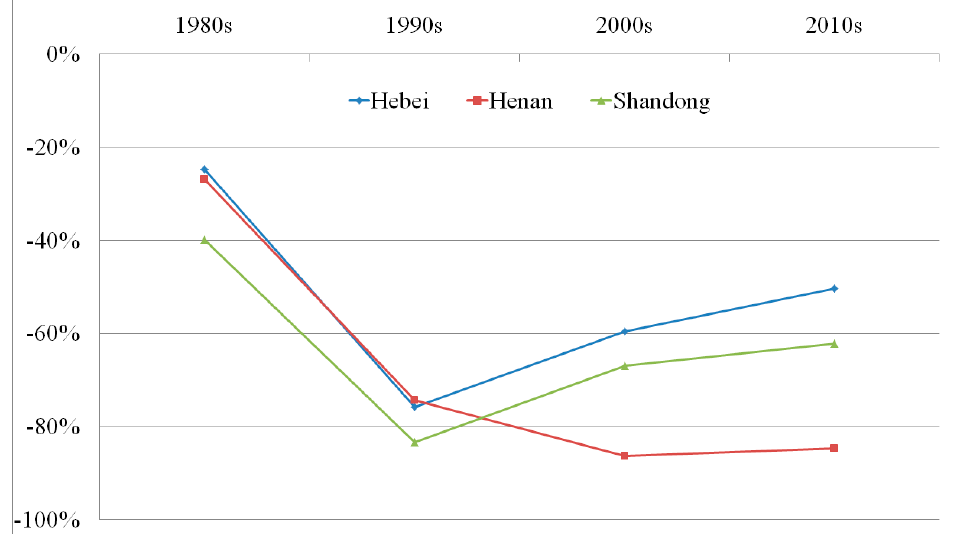
Figure 3. The decadal agricultural drought affected area changes (ADAC) during the period of March-May in the period of 1981–2018 for Hebei, Henan and Shandong Provinces.